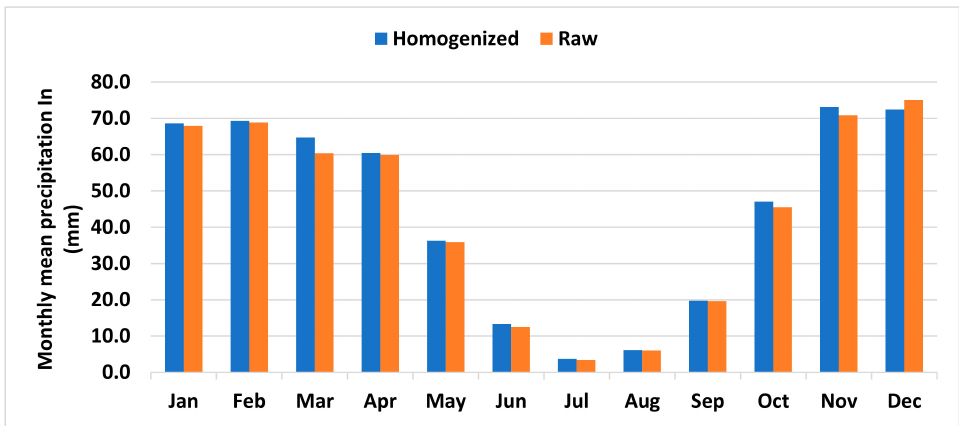
Figure 7. Monthly means of raw and homogenized data for all data available for the region.